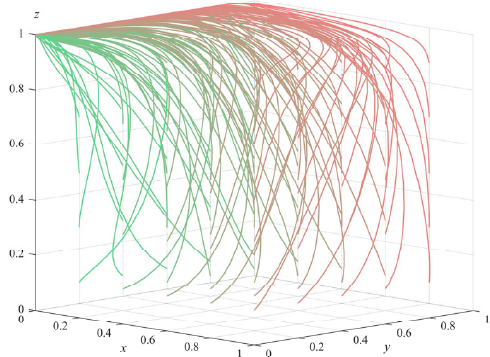
Figure 1. Simulation results of Proposition 1.